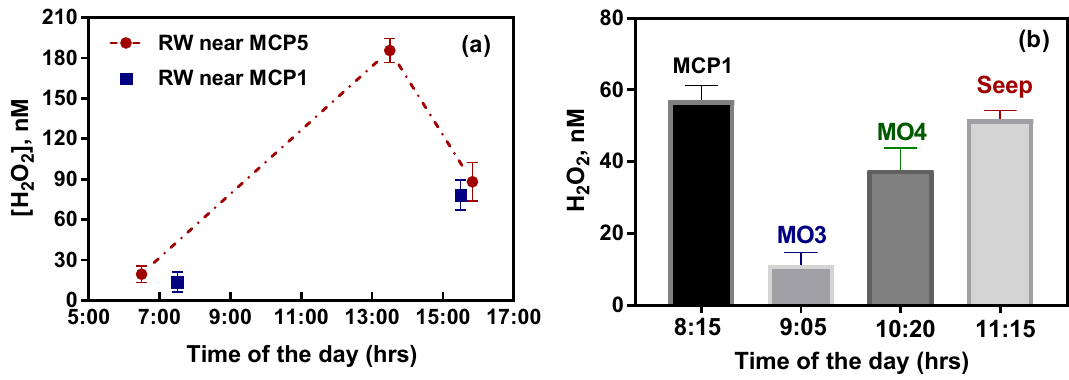
Figure 3. ( a ) Diel changes of H 2 O 2 in surface river waters adjacent to MCP5 (red circles) and MCP1 (blue squares), with dashed line shown just as connections between data points; ( b ) H 2 O 2 concentrations in groundwater measured at other locations of the East River site. Error bars are the standard errors from triplicate